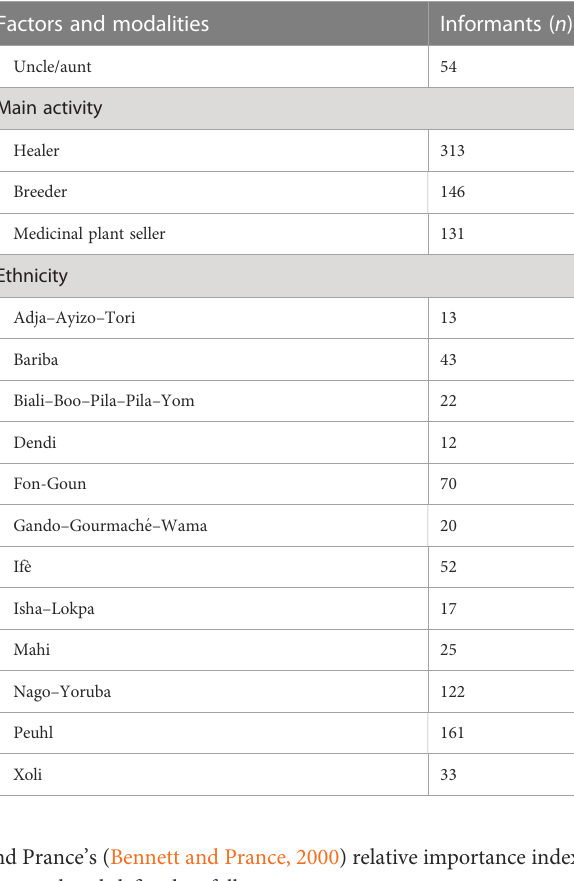
TABLE 1 Phytodistricts and informants sociodemographic